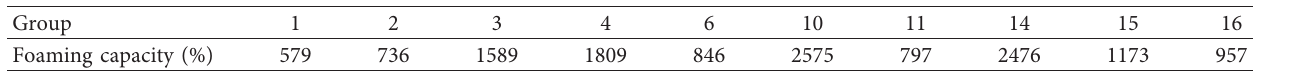
Table 7: Test results of grout foaming capacity.